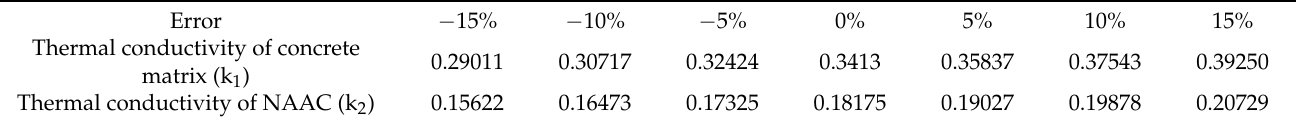
Table 9. Effect of concrete matrix thermal conductivity on the thermal conductivity of NAAC.